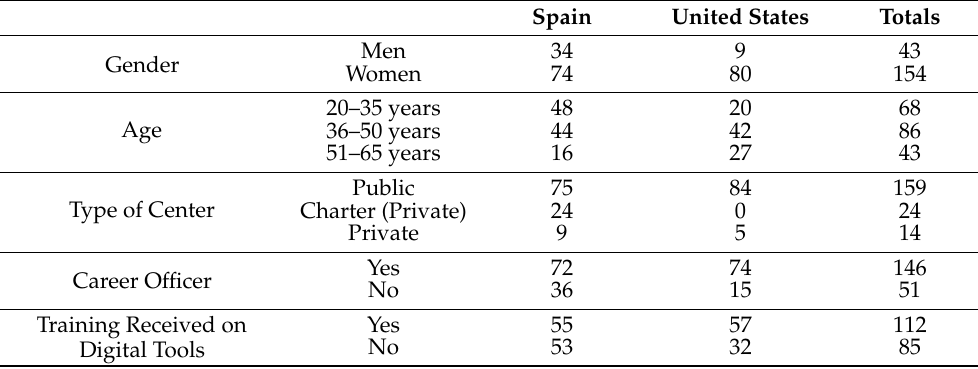
Table 1. Sociodemographic data of the